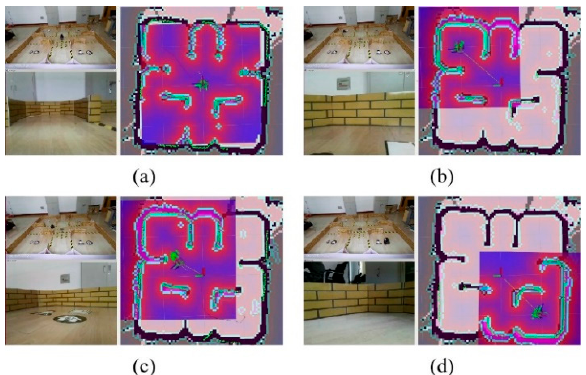
Figure 19. The sequence of snapshots for the execution of the task: “PutHandbookonBookshelf”. ( a ) The initial position of TurtleBot3; ( b ) The atomic action of MovetoHandbook. ( c ) The atomic action MovetoLeo; ( d ) The arrival at the position of Leo.